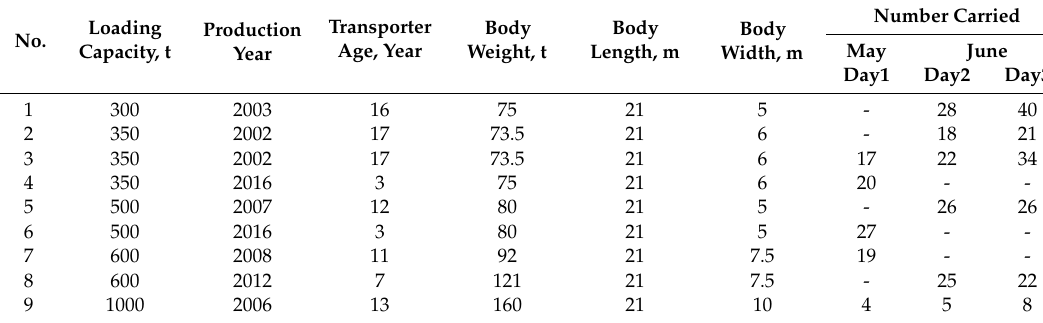
Table 1. Characteristics of transporters and the number carried by measurement